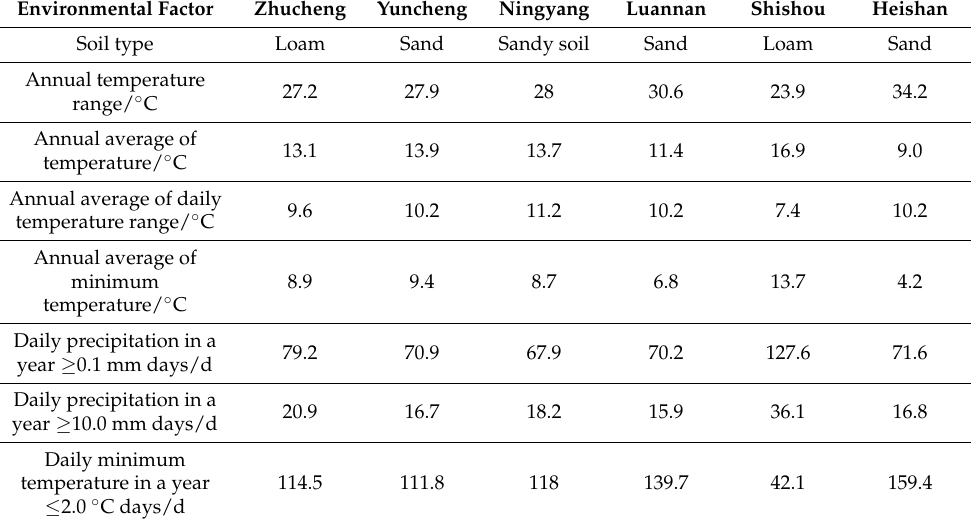
Table 1. Environmental conditions at the six sites. The listed factors include light, temperature, and water, which mainly affect growth indicators. The areas’ extreme temperature values are also included. The meteorological data are the annual average values of environmental indicators in the past two decades, and the sunshine duration is the average value in 2017 and